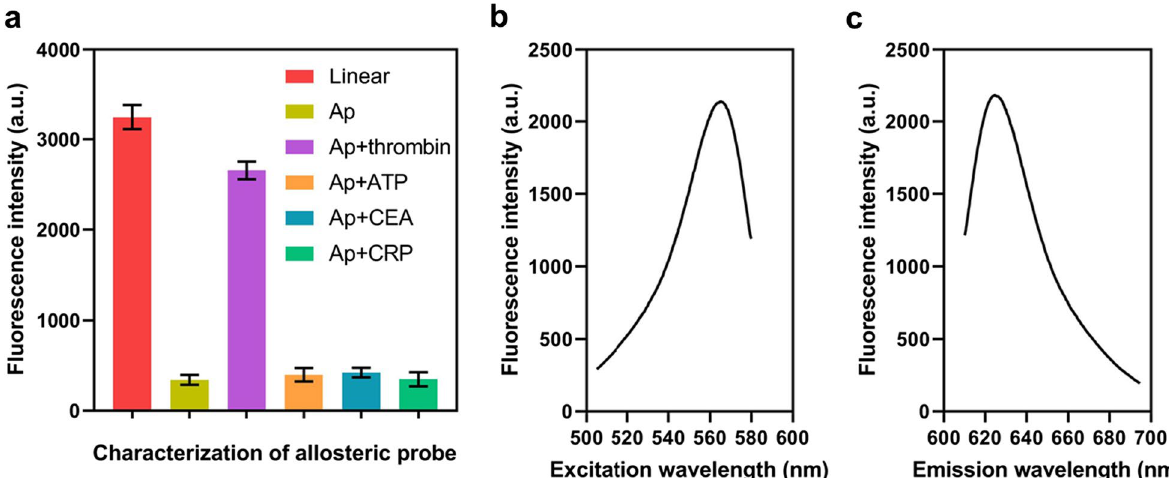
Fig. 2 Characterization of allosteric probe and DNA polymerase and endonuclease-assisted chain extension. a Fluorescence intensities of the linear allosteric probe and hairpin structure allosteric probe (Ap); b excitation spectra of the DNA-templated AgNCs. c Emission spectra of the DNA-templated